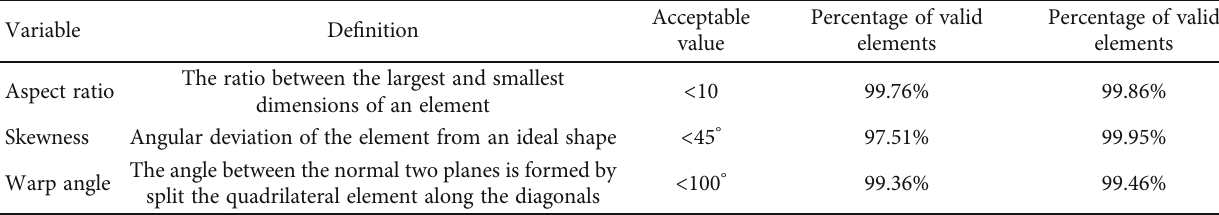
Table 3: Mesh quality checks for bicycle and passive security system model.